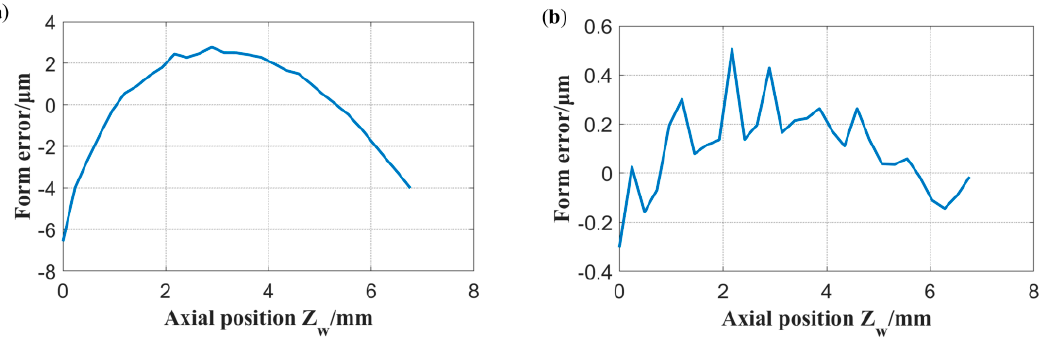
Figure 10. Formation error of a meridian: ( a ) initial error, ( b ) residual error after compensation.